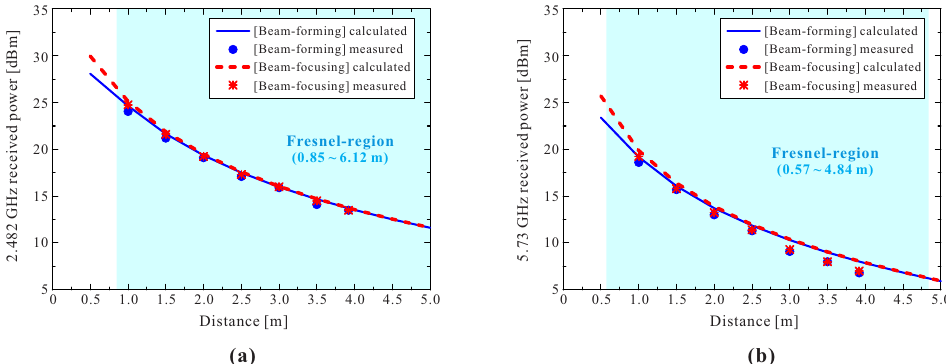
Figure 15. Measured and calculated results of the received power according to the transmission distance: ( a ) 2.482 GHz; ( b ) 5.73